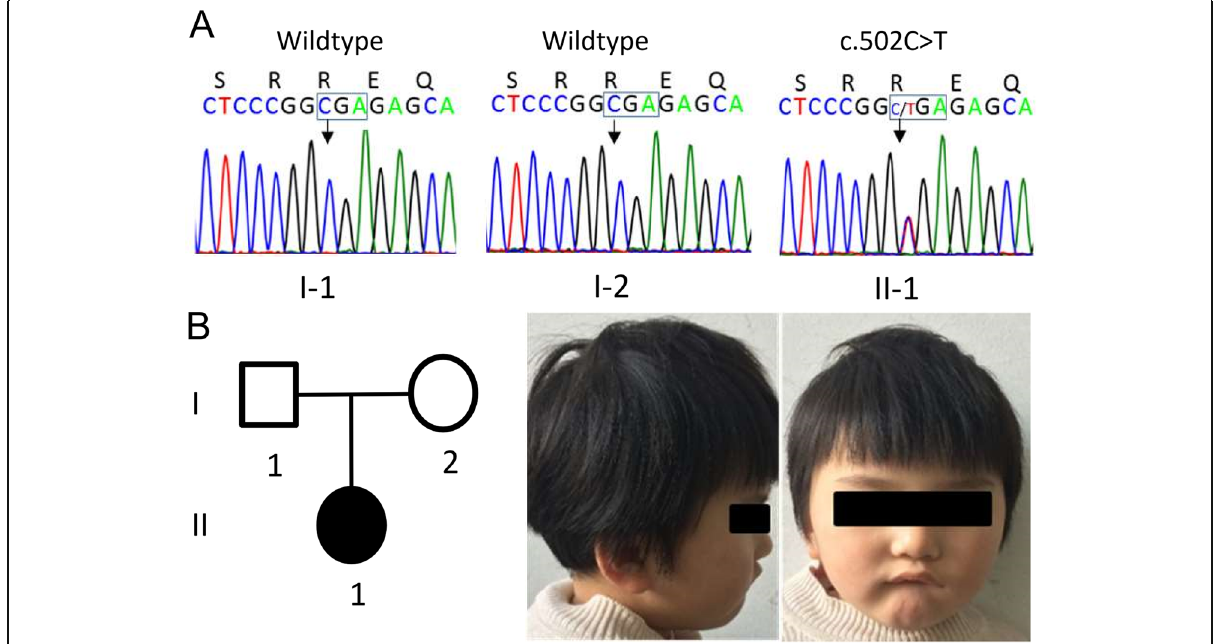
Fig. 1 Family 1 and verification of a de novo nonsense mutation c.502C > T, p.(Arg168*) of MECP2 . a The mutation is detected in the proband, but not in the parents, is confirmed by Sanger sequencing. b Pedigree of the family and facial photograph of the proband at 3 years old